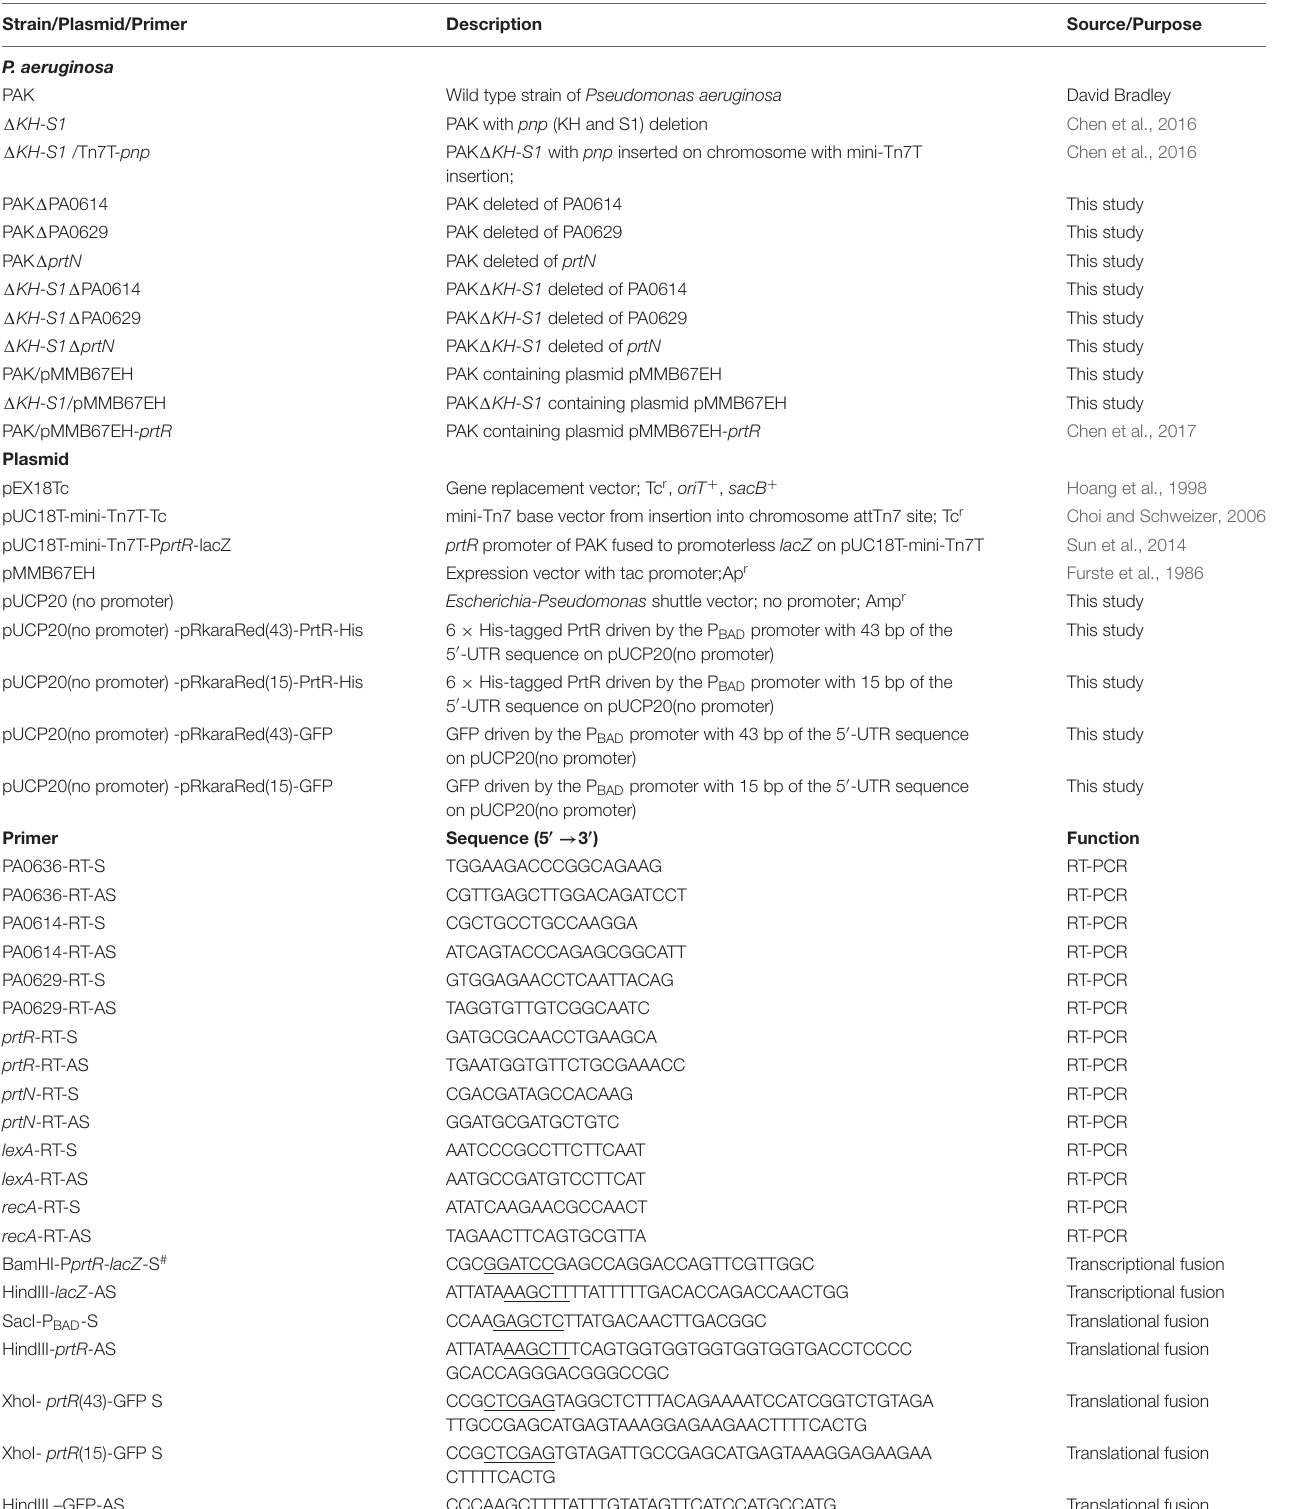
TABLE 1 | Bacterial strains, plasmids and primers used in this